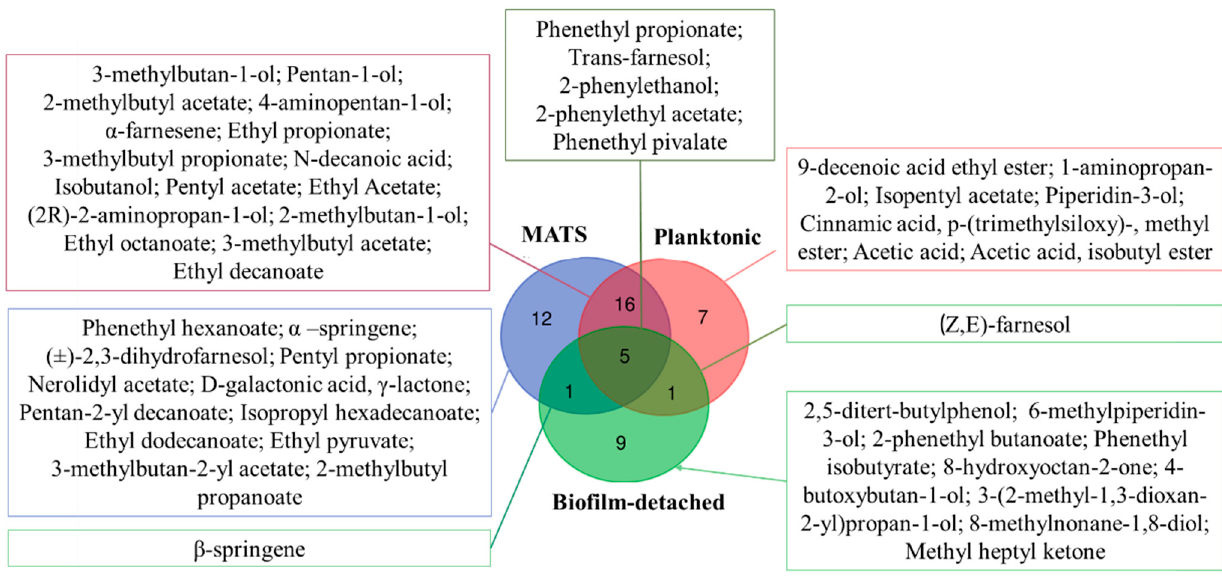
Figure 3. Venn diagram depicting the similarities and differences of VOCs produced in the different lifestyles.